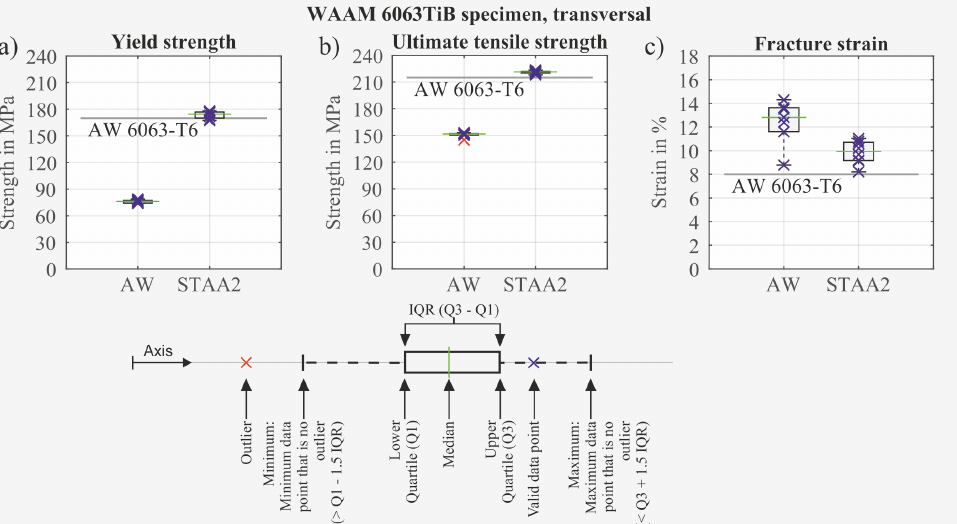
Figure 8. Strength properties of transversal WAAM AW 6063TiB specimens for different PWHT strategies ( a ) yield strength, ( b ) ultimate tensile strength and ( c ) fracture strain.